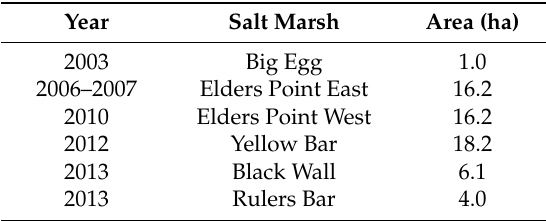
Table 5. Salt marsh restoration site, year, and extent